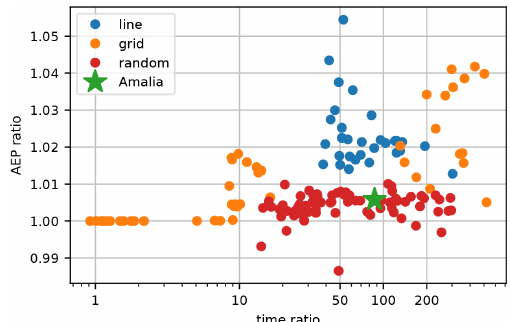
Figure 13. The aggregate results of optimizations run in this paper. The y axis shows the AEP ratio, which is the optimal AEP from the continuous yaw optimization divided by the optimal AEP from our Boolean optimization. The x axis shows the time ratio, which is the time to run the continuous optimization divided by the time to run our Boolean optimization. Each color represents optimizations run for the different scenarios, as indicated by the